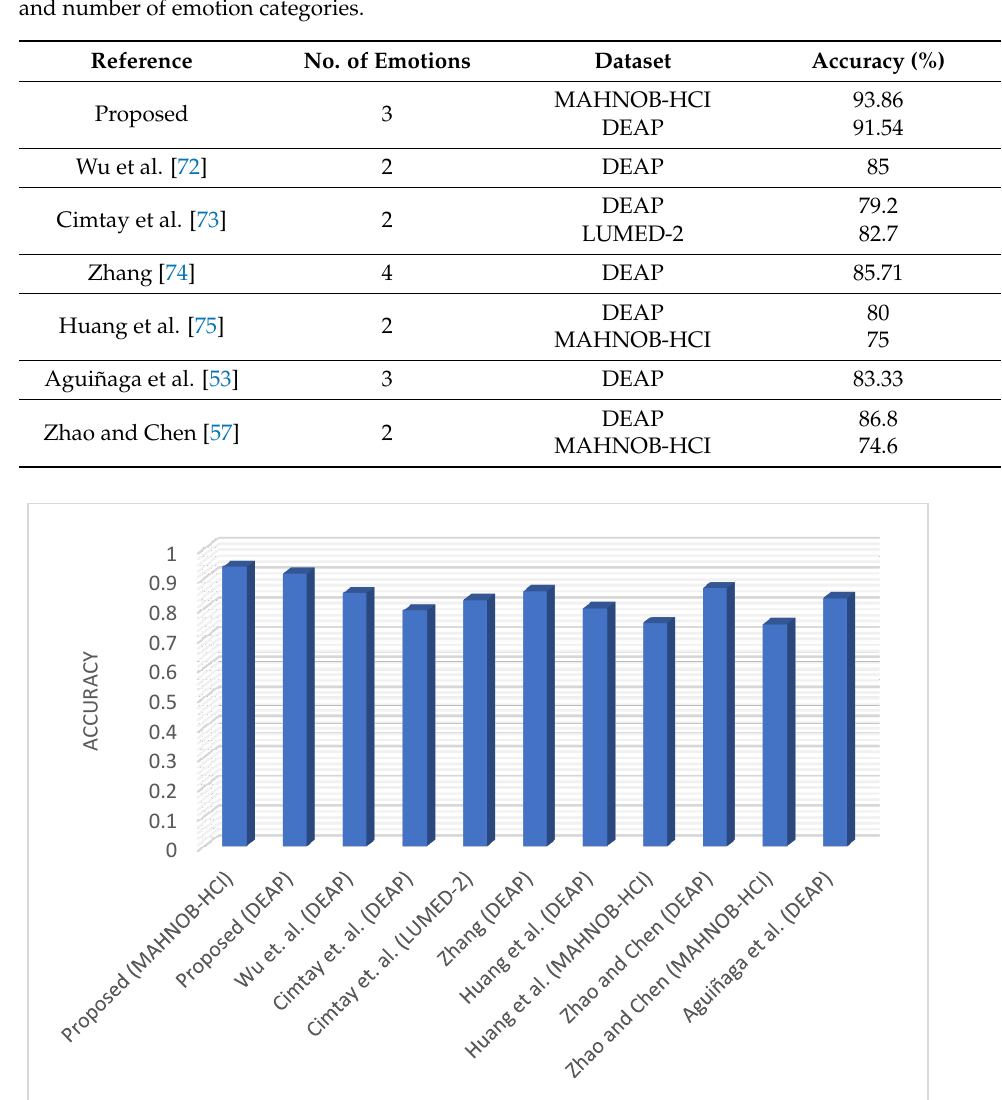
Figure 7. Comparison of proposed method with other state-of-the-art methods from the literature in terms of accuracy (Aguiñaga et al. [53], Zhao and Chen [57], Wu et al. [72], Cimtay et al. [73], Zhang [74], Huang et al. [75]).